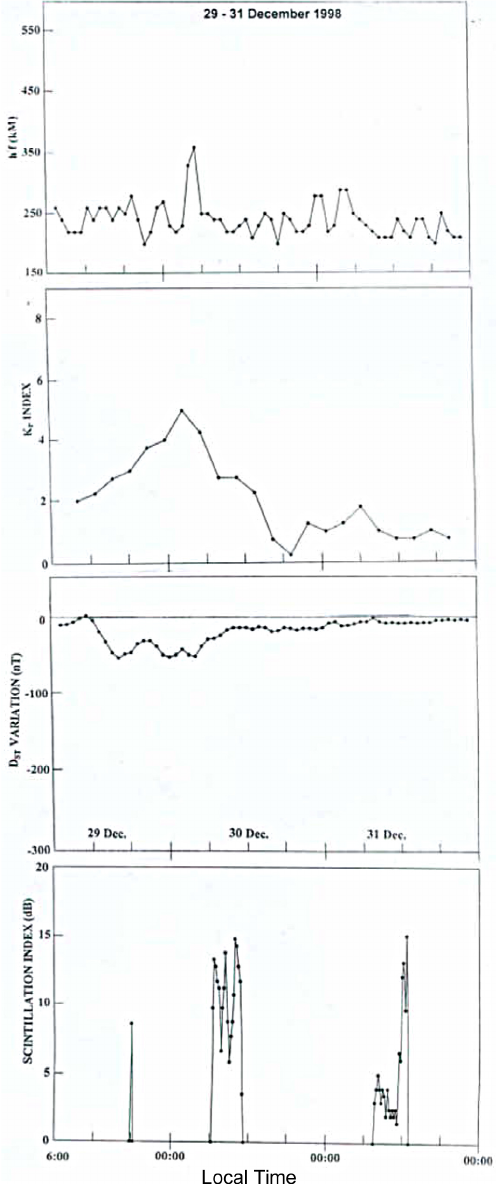
Fig. 8. Example of a magnetic storm that occurred during 29 − 31 December 1998. The top panel is ionospheric F-layer height (h 0 F) at Ahmedabad, the two middle panels are K p and D st and the bot- tom panel shows the occurrence times of scintillation activity at